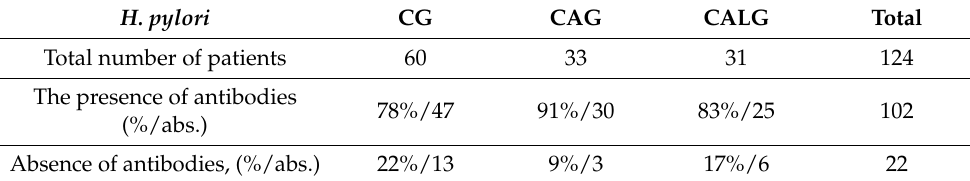
Table 2. Helicobacter pylori infection in various types of chronic gastritis (%/abs.).